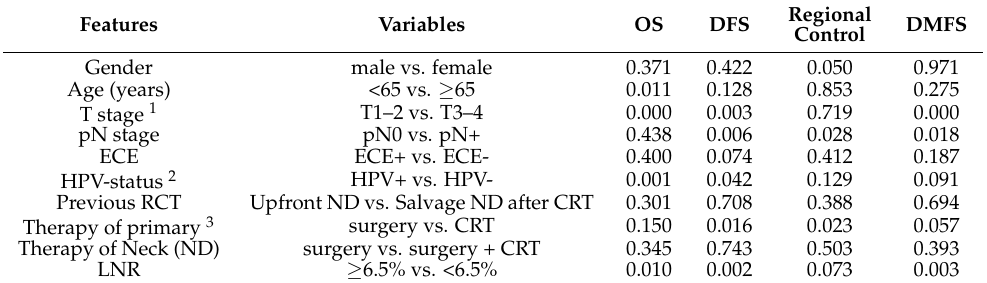
Table A4. Univariate analysis of modified radical neck dissection factors associated with survival. n =